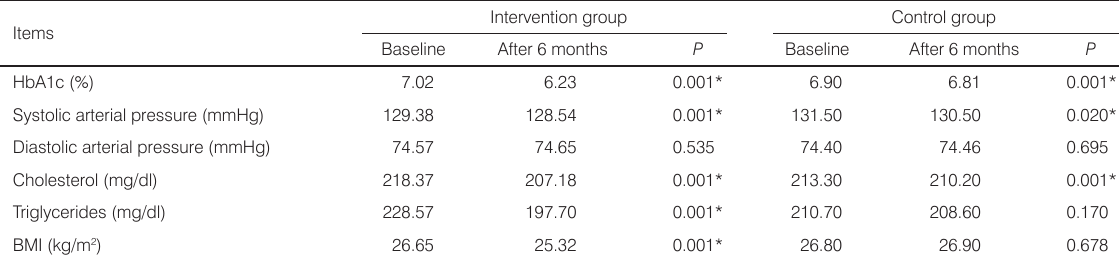
Table 4. Values of clinical and biochemical characteristics of the participants at the end of the